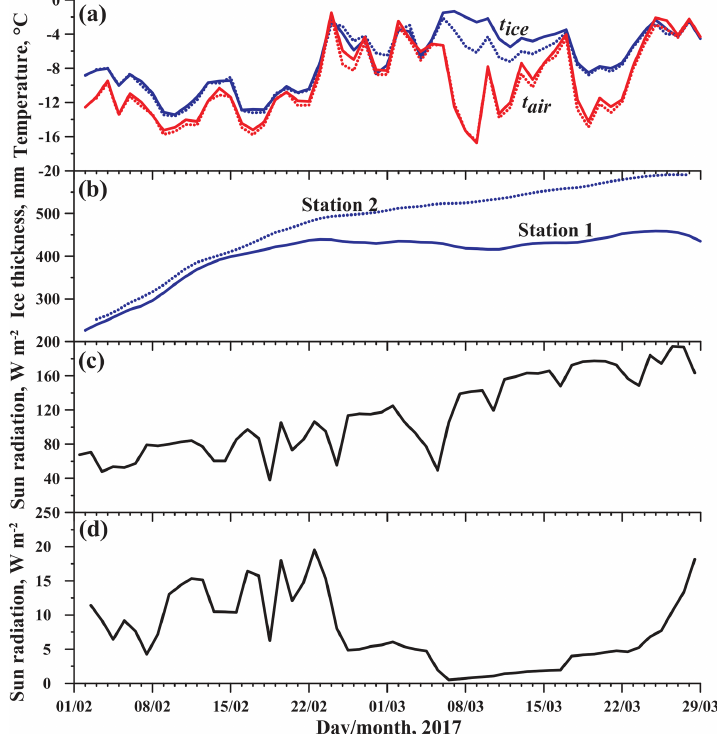
Figure 2. Background data on the Lake Baikal ice regime during the observations: (a) daily averaged temperatures of ice surface ( t ice ) and air temperatures at 1.5m above the ice ( t air ), (b) ice thickness, (c) incoming solar radiation, and (d) penetrated solar radiation. In (a) and (b) solid lines correspond to station S1 and dotted lines are for station S2.